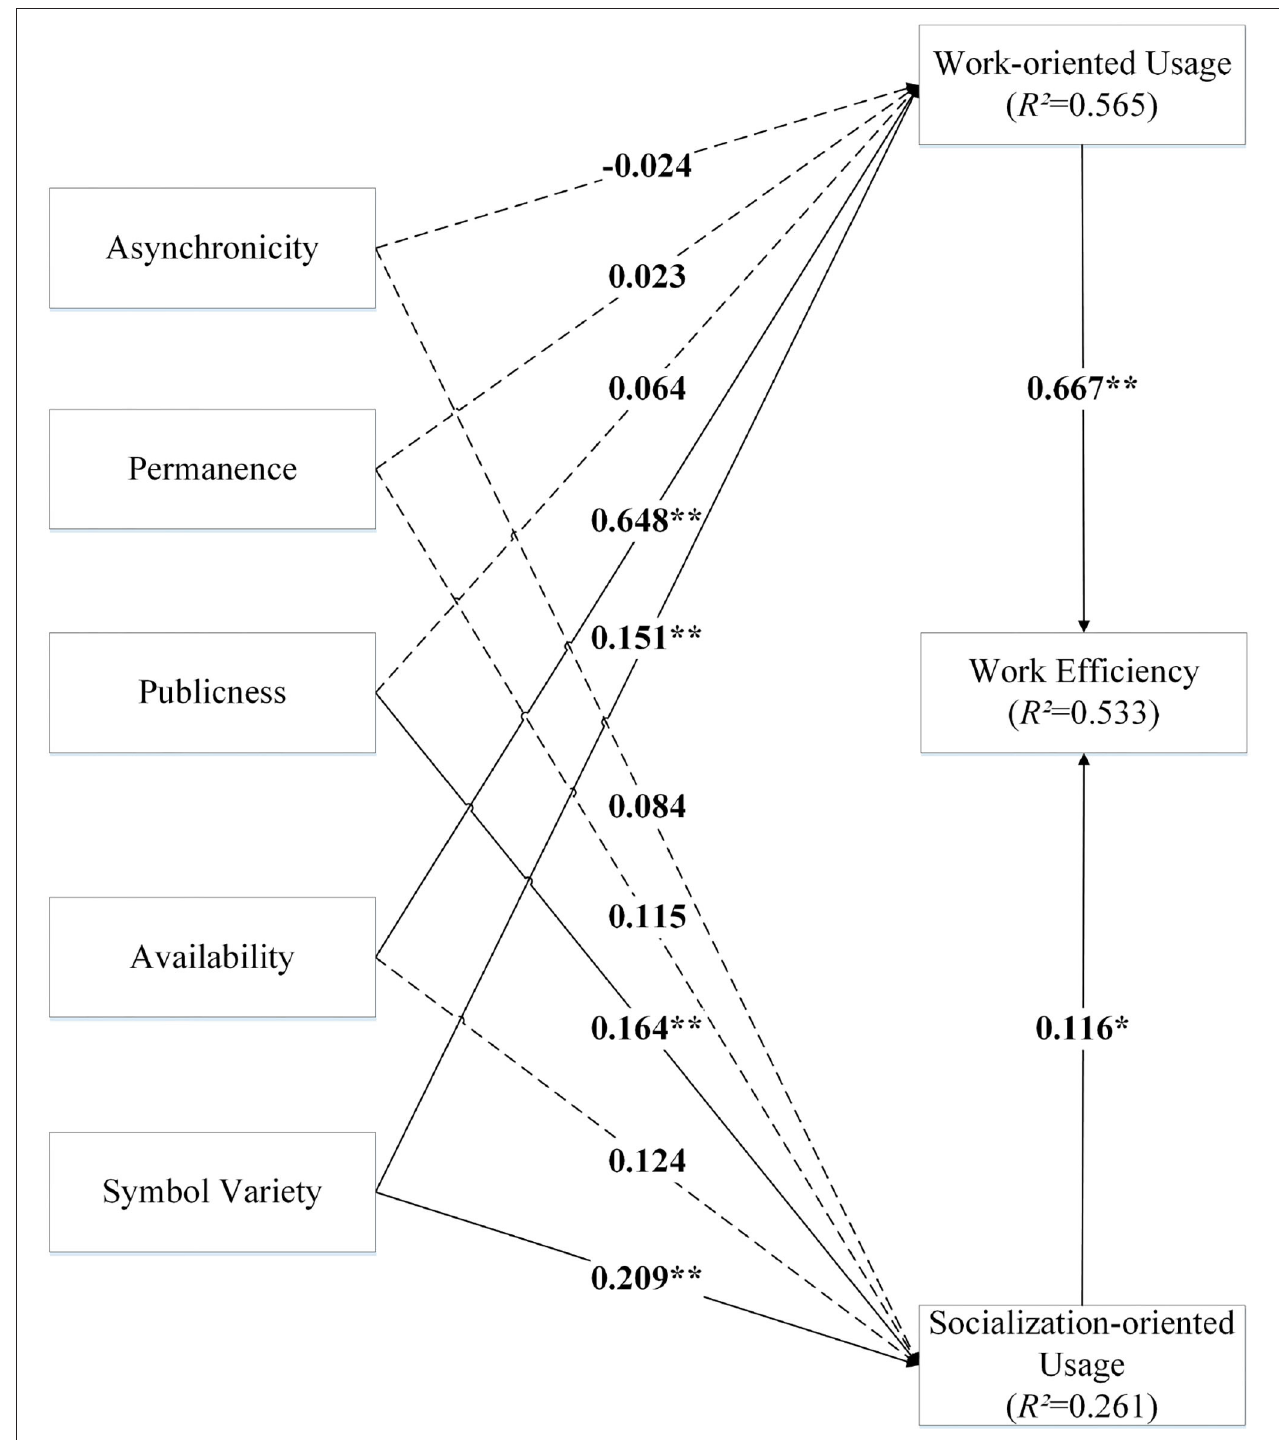
FIGURE 2 | Result of path analysis. Note: * p -value < 0.05; ** p -value < 0.01.